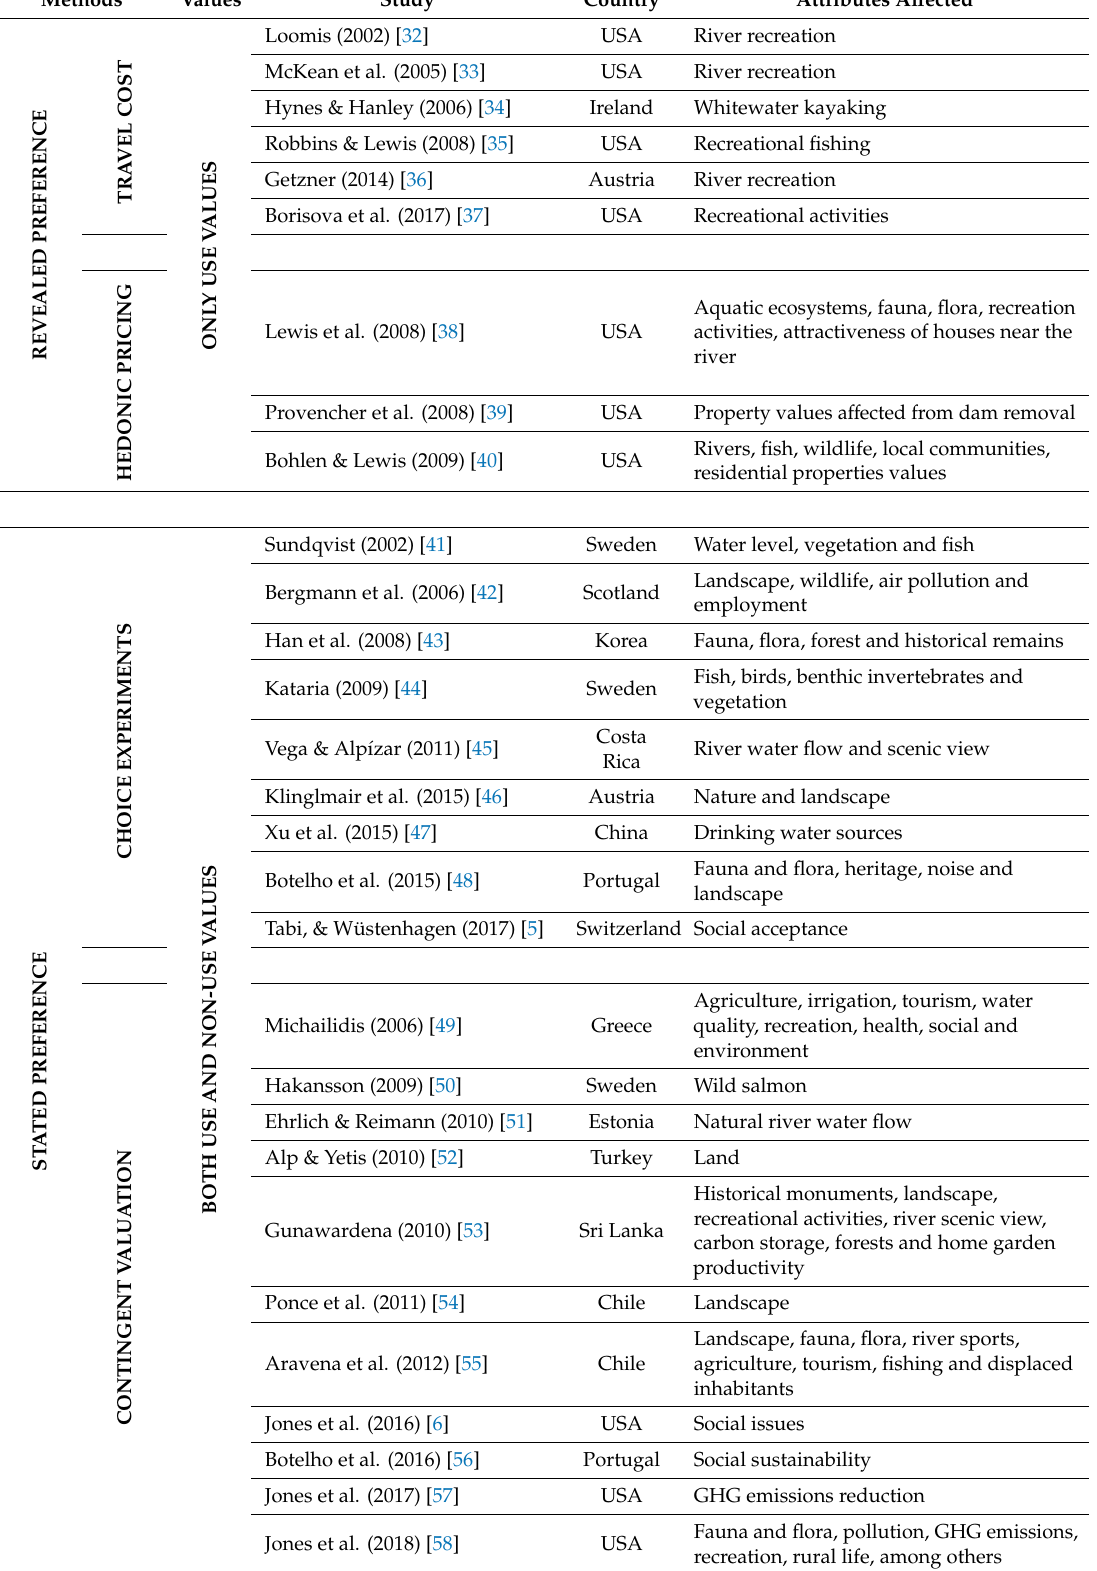
Table 1. Economic Valuation of the Dams’